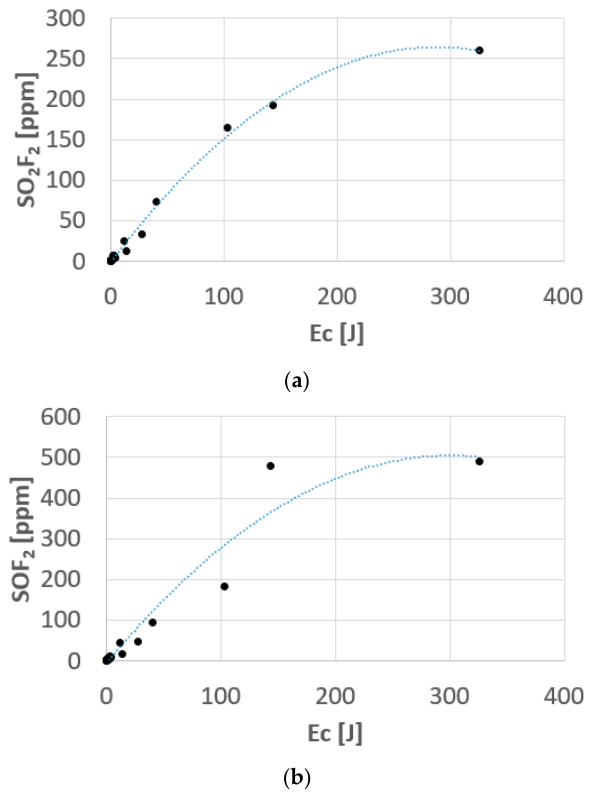
Figure 7. Finite element method electric field result (1000 pC, 15 kV applied). ( a ) electric field distribution, ( b ) high energy